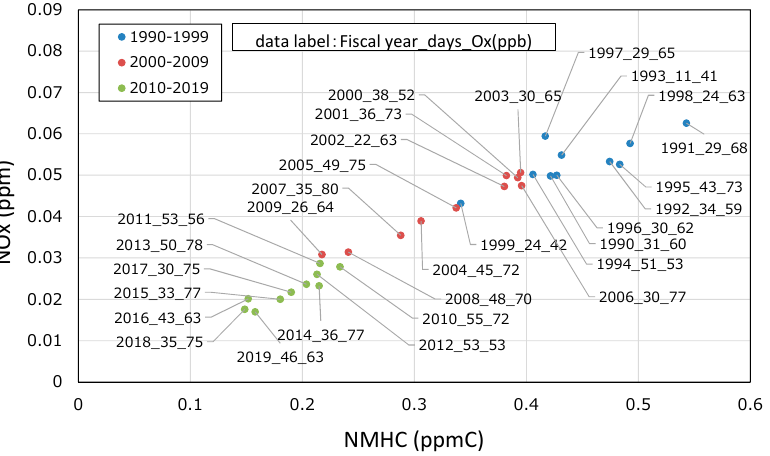
Figure 27. Relationship between Ox, NOx, and NMHC on extracted days. Ox: figure averaged for the number of extracted days of the average for all nine General sta. of the daily maximum of extracted-day hourly values. NOx: figure averaged for the number of extracted days of the average for all nine General sta. of the extracted-day three-hour average from 6 a.m. to 9 a.m. NMHC: figure averaged for the number of extracted days of the average for seven General sta. of the extracted-day three-hour average from 6 a.m. to 9 a.m. Days: number of extracted days.